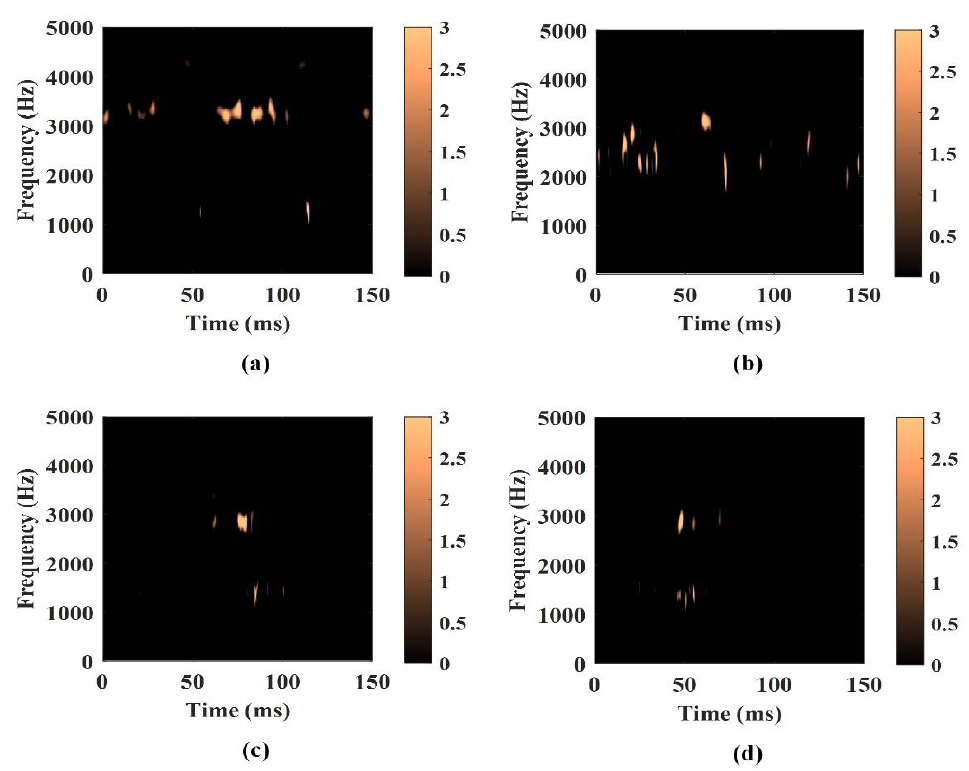
Figure 12. Figure 12. Two-dimensional time – frequency images of four different operating conditions: ( a ) S1